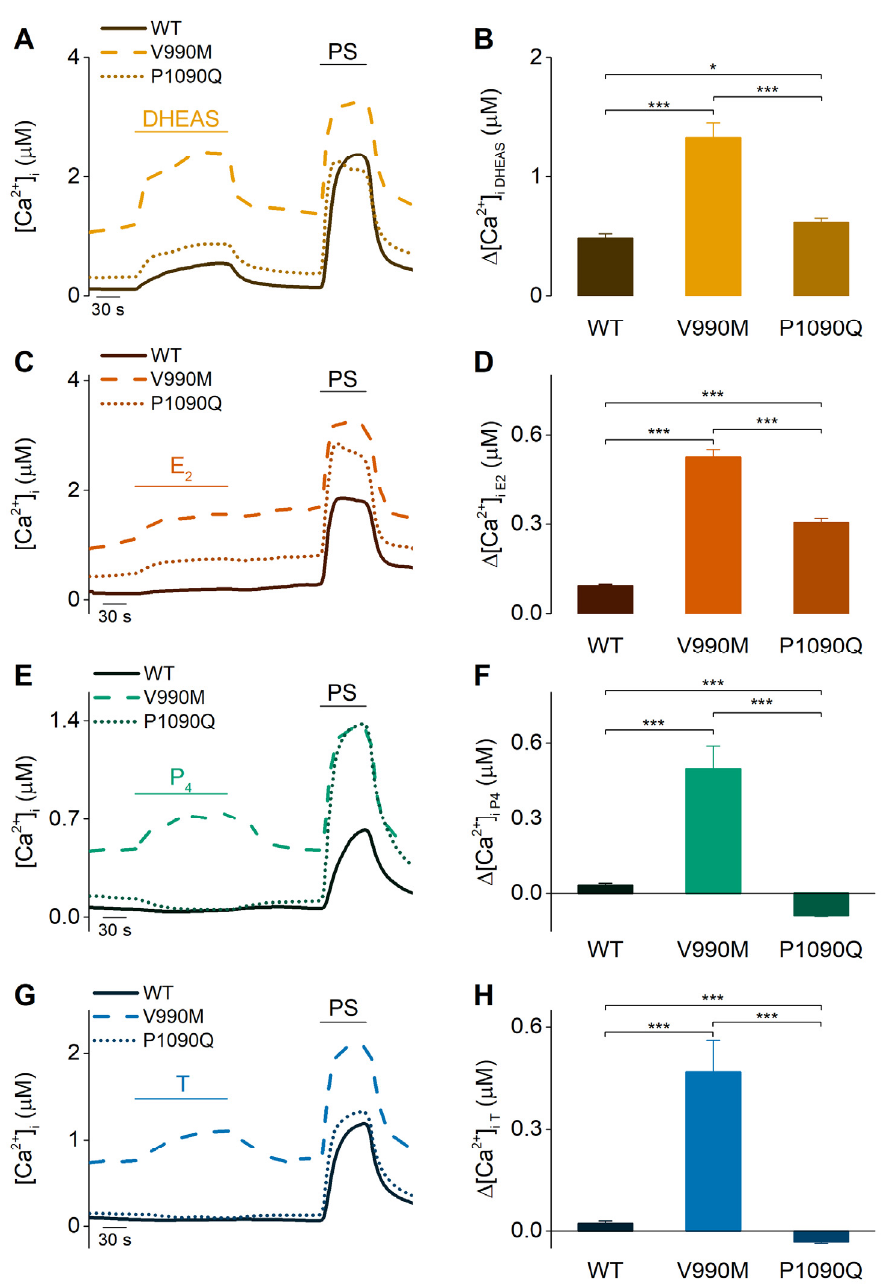
Figure 6. DHEAS, estradiol, progesterone, and testosterone showed altered responses in TRPM3 disease-mutations. ( A , C , E , G ) Time course of intracellular calcium [Ca 2+ ] i in wild-type (WT), V990M or P1090Q transfected HEK293T cells upon application of DHEAS (100 µ M), E 2 (100 µ M), P 4 (300 µ M) or T (300 µ M), respectively. ( B , D , F , H ) Corresponding amplitudes of the calcium imaging experiments (with N = 3 for DHEAS: WT: n = 174, VM: n = 203, PQ: n = 196; N = 4 for E 2 : WT: n = 242, VM: n = 264, PQ: n = 186; N = 3 for P 4 : WT: n = 635, VM: n = 491, PQ: n = 823; N = 3 for T: WT: n = 605, VM: n = 463, PQ: n = 603). Data are represented as mean ± SEM. Statistical analysis using a Kruskal- Wallis test. p < 0.05 *, p < 0.001 ***. p -values for ( B ): WT/VM: p < 1 × 10 − 15 , WT/PQ: p = 0.0122, VM/PQ: p = 1.29 × 10 − 12 ; ( D ): WT/VM and WT/PQ: p < 1 × 10 − 15 , VM/PQ: p = 1.59 × 10 − 6 ; ( F ): WT/VM: p = 1.87 × 10 − 13 , WT/PQ and VM/PQ: p < 1 × 10 − 15 ; ( H ): WT/VM, WT/PQ and VM/PQ: p < 1 × 10 − 15 .